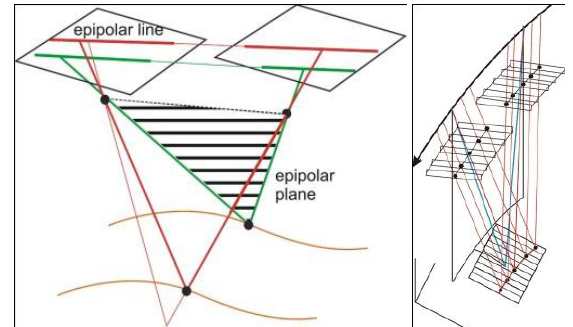
Figure 15. Left: Epipolar lines in perspective images, Right: Epipolar geometry for line scanner